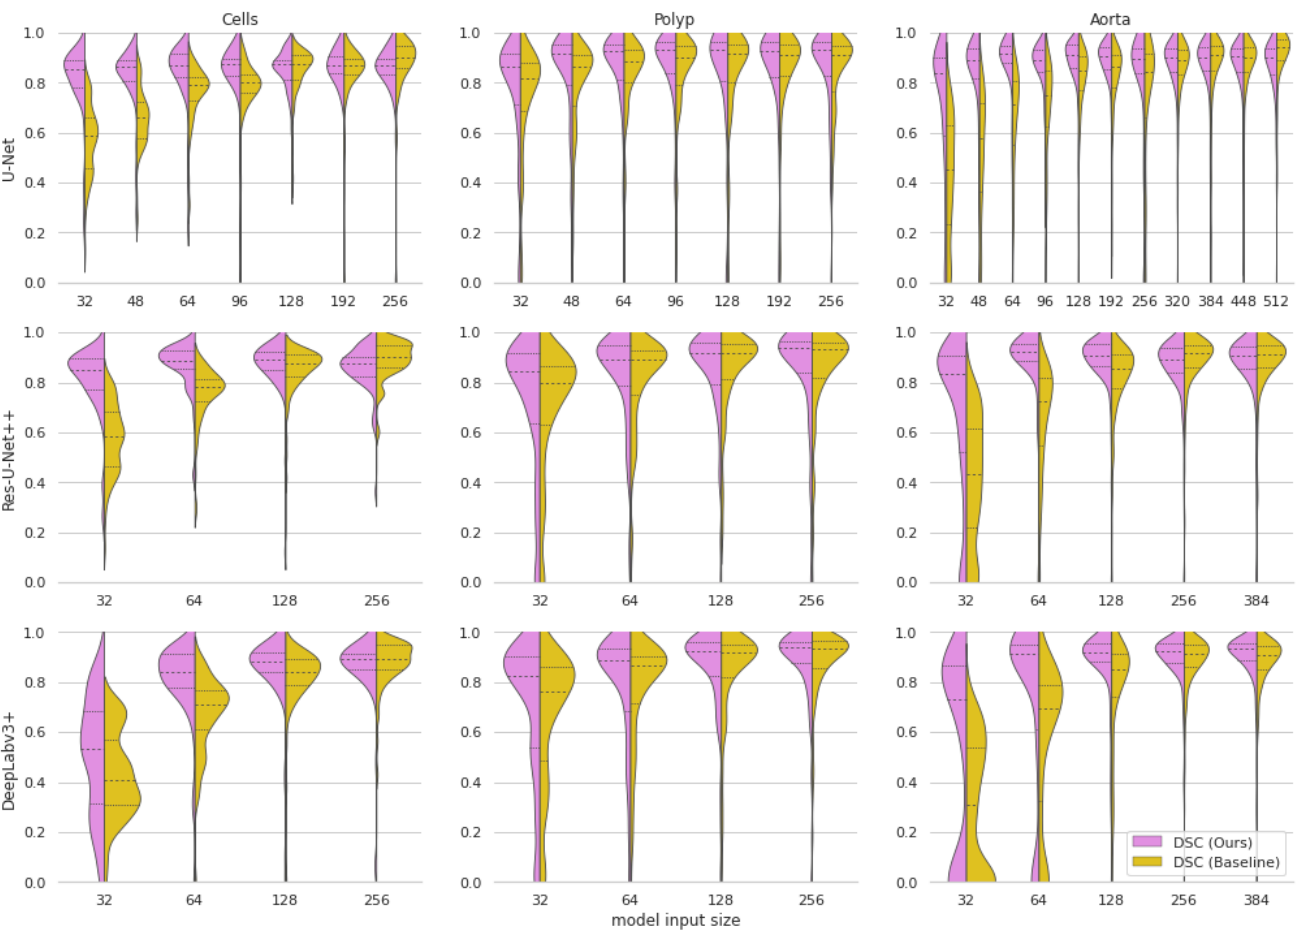
Figure 3. Violin plots of Dice Score Coefficients of our approach compared to the baseline models at various input dimensions. The dashed lines represent quartiles of the